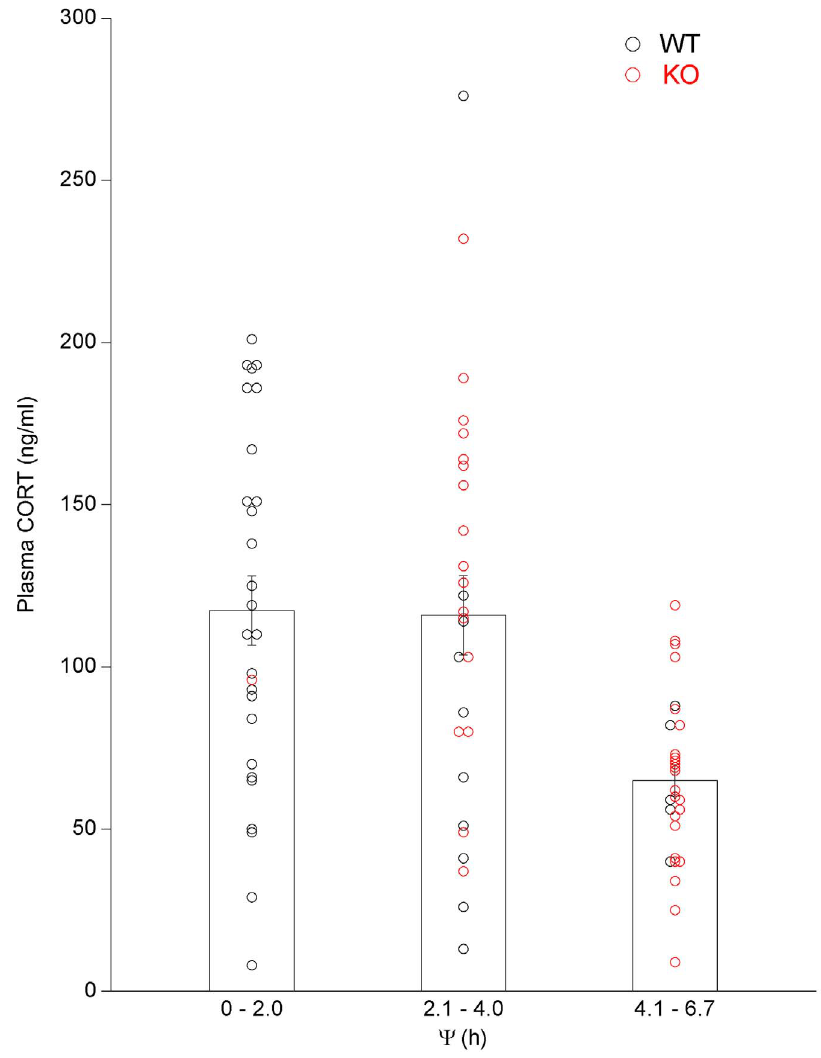
Figure 5. Peak plasma CORT levels of wild type and 5-HT 1B knockout mice in 9.5L:13.5D. Plasma CORT values, determined 1 h prior to activity onset after 21–23 cycles in 9.5L:13.5D for wild type (WT) and 5-HT 1B knockout (KO) animals, assembled into groups based on the animals phase angle of entrainment ( Y , activity onset relative to light offset). Peak CORT levels are significantly attenuated in animals with Y s delayed . 4 h after light offset (p , 0.01); (n)=27–29